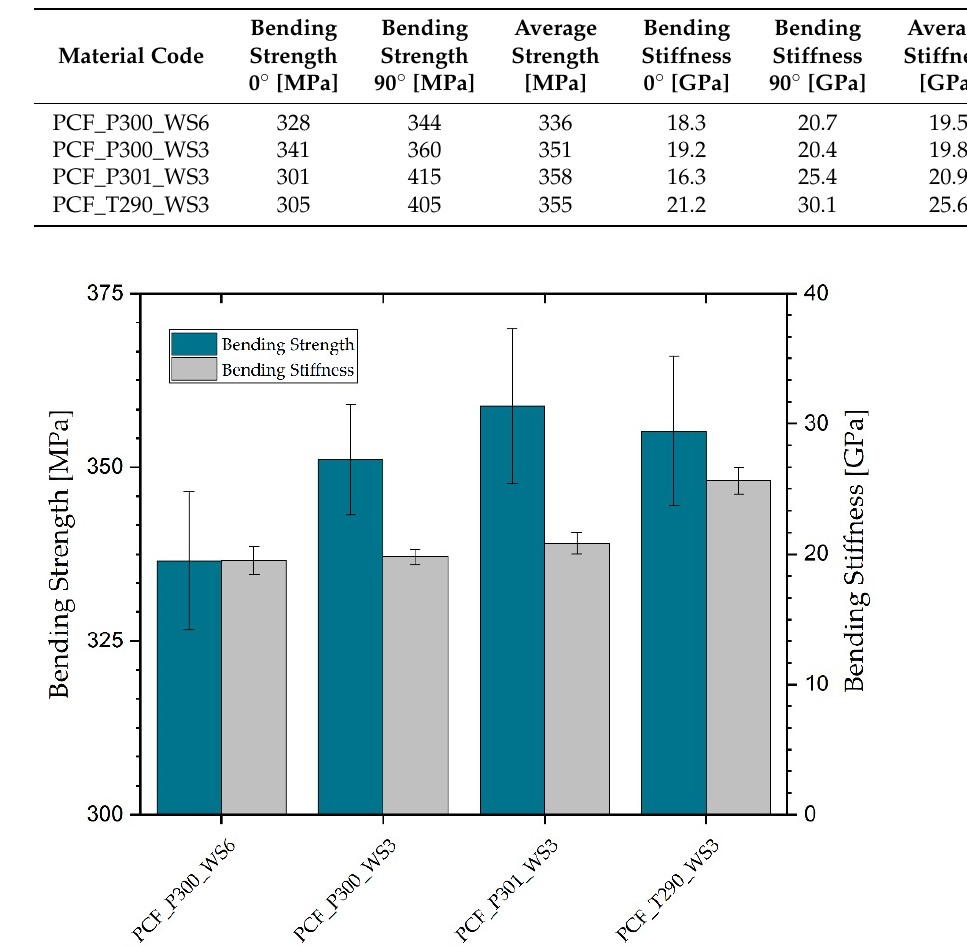
Table 8. The 0° and 90° properties of nonwovens using different polymer types. Table 8. The 0 ◦ and 90 ◦ properties of nonwovens using different polymer types.